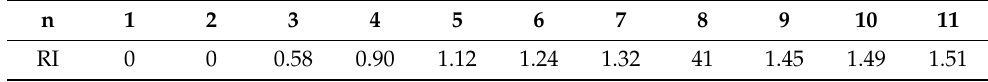
Table 3. Values of random consistency indicator